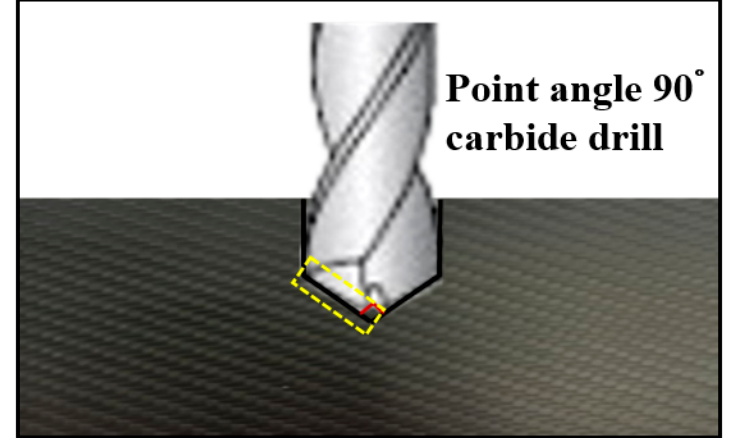
Figure 4. Tool wear position in drilling operation.